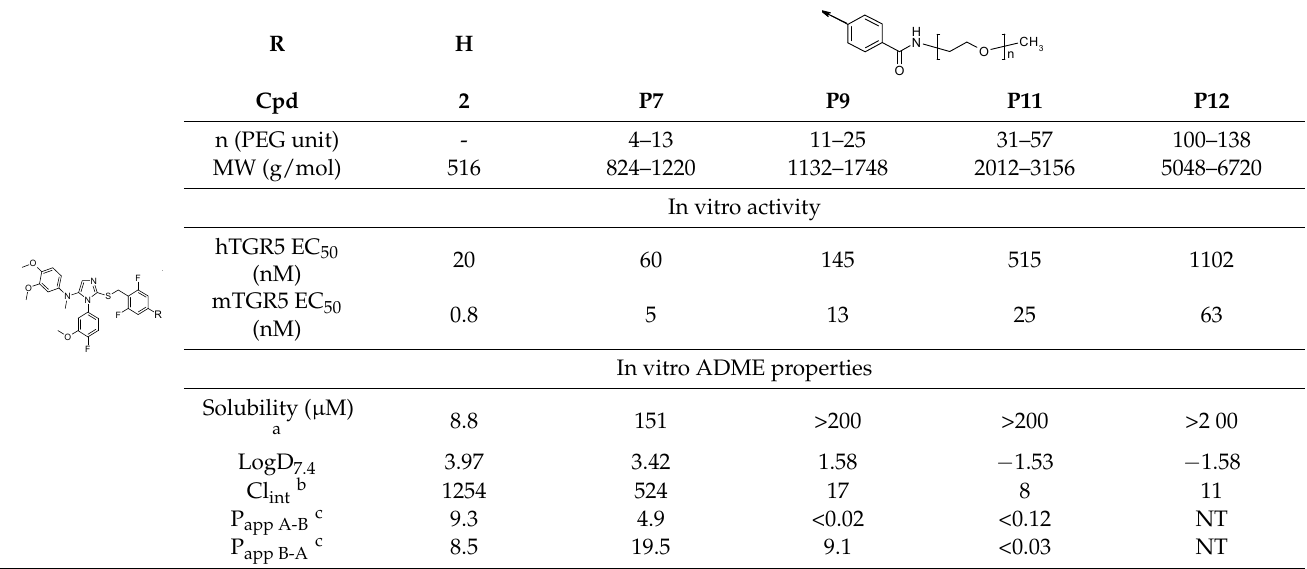
Table 2. In vitro pharmacological, physico-chemical and ADME parameters of PEGylated compounds (P7, P9, P11, P12) compared to the parent agonist (Cpd2) [46].